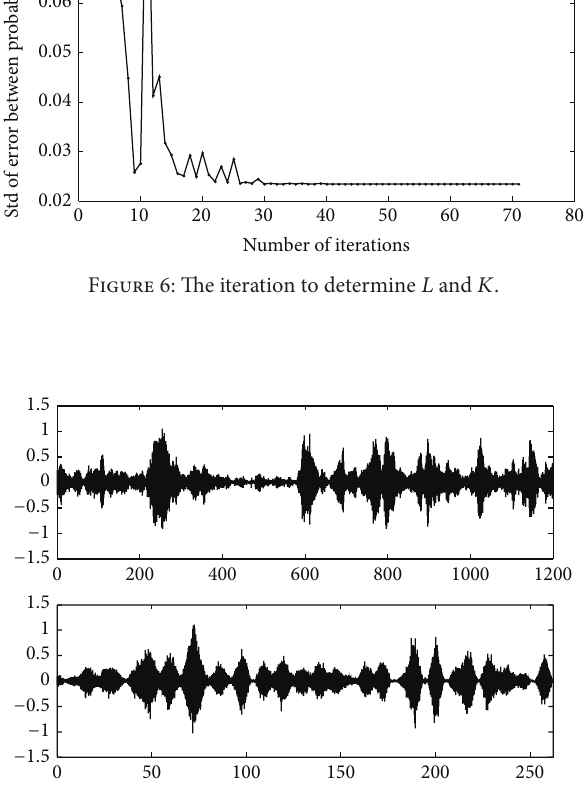
Figure 7: Field data and synthesized non-Gaussian signal.